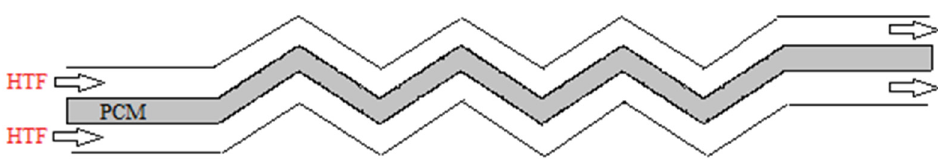
Figure 2. The schematic of the proposed system including the PCM layer and heat transfer fluids (HTF) (air).